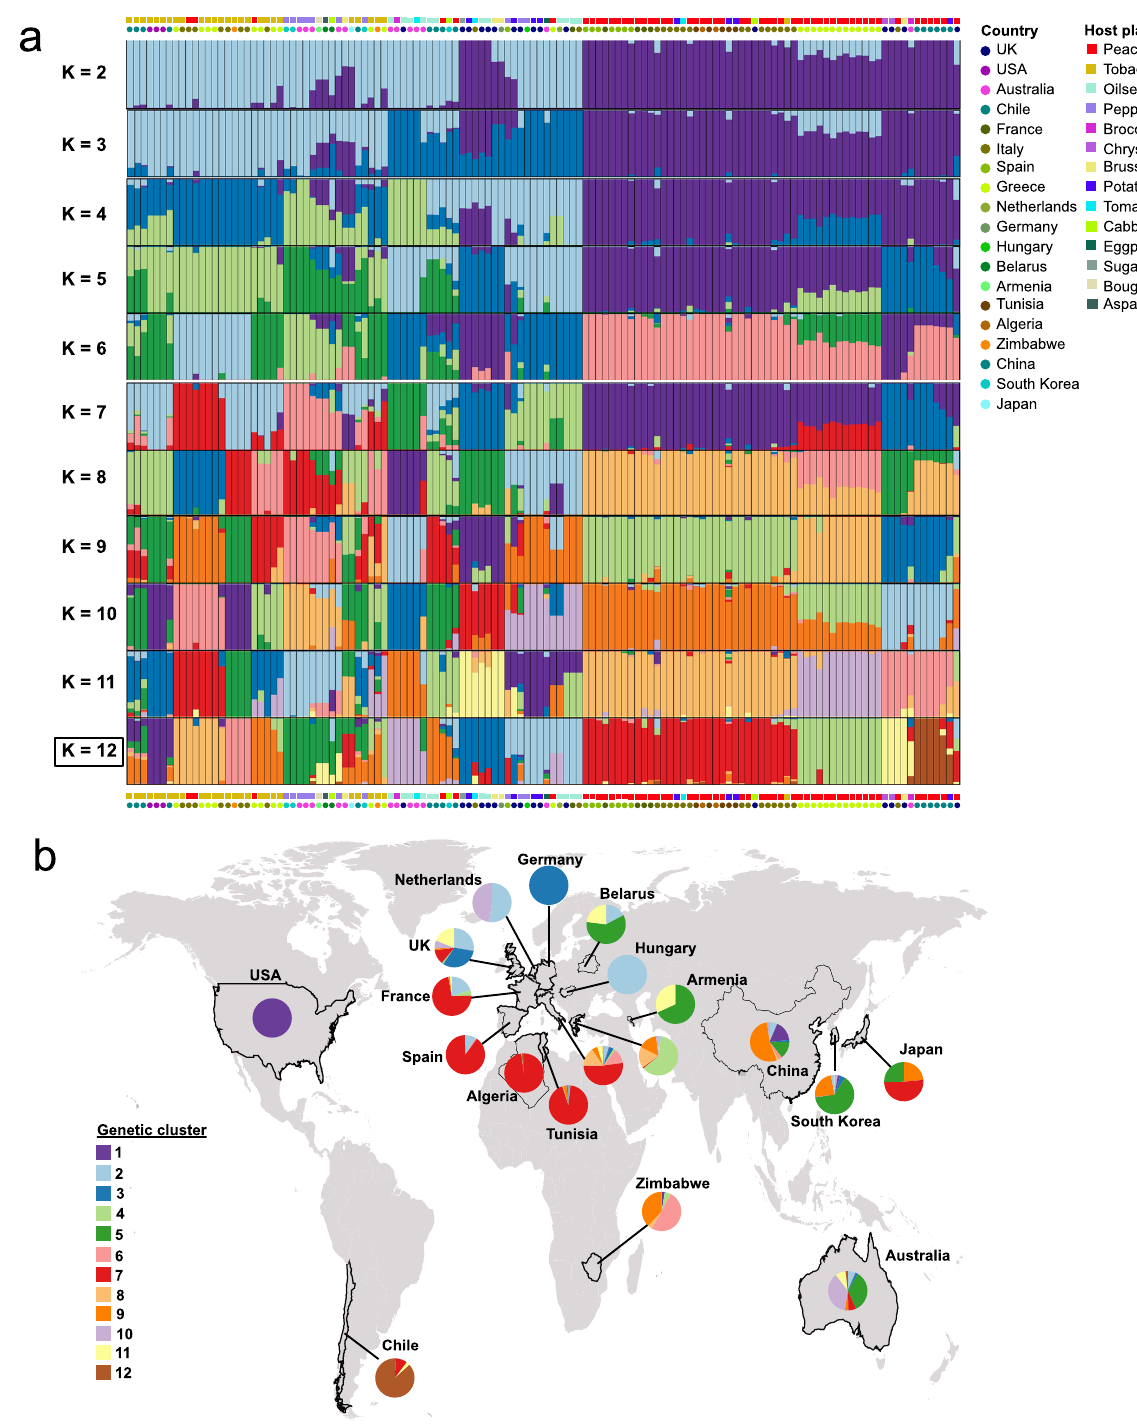
Fig. 3 Genetic structure in globally sampled M. persicae . a Admixture analysis of genetic structure and individual ancestry. Colours in each column represent the inferred proportion of ancestry when K is varied from 2 to 12, the most likely number of predicted genetic clusters (K = 12) is indicated by a box. The geographic origin of clones and the host plant from which they were collected are indicated above and below the structure plot by coloured circles and squares respectively. b Geographic representation of genetic structure in the clones when grouped by country of origin (K =